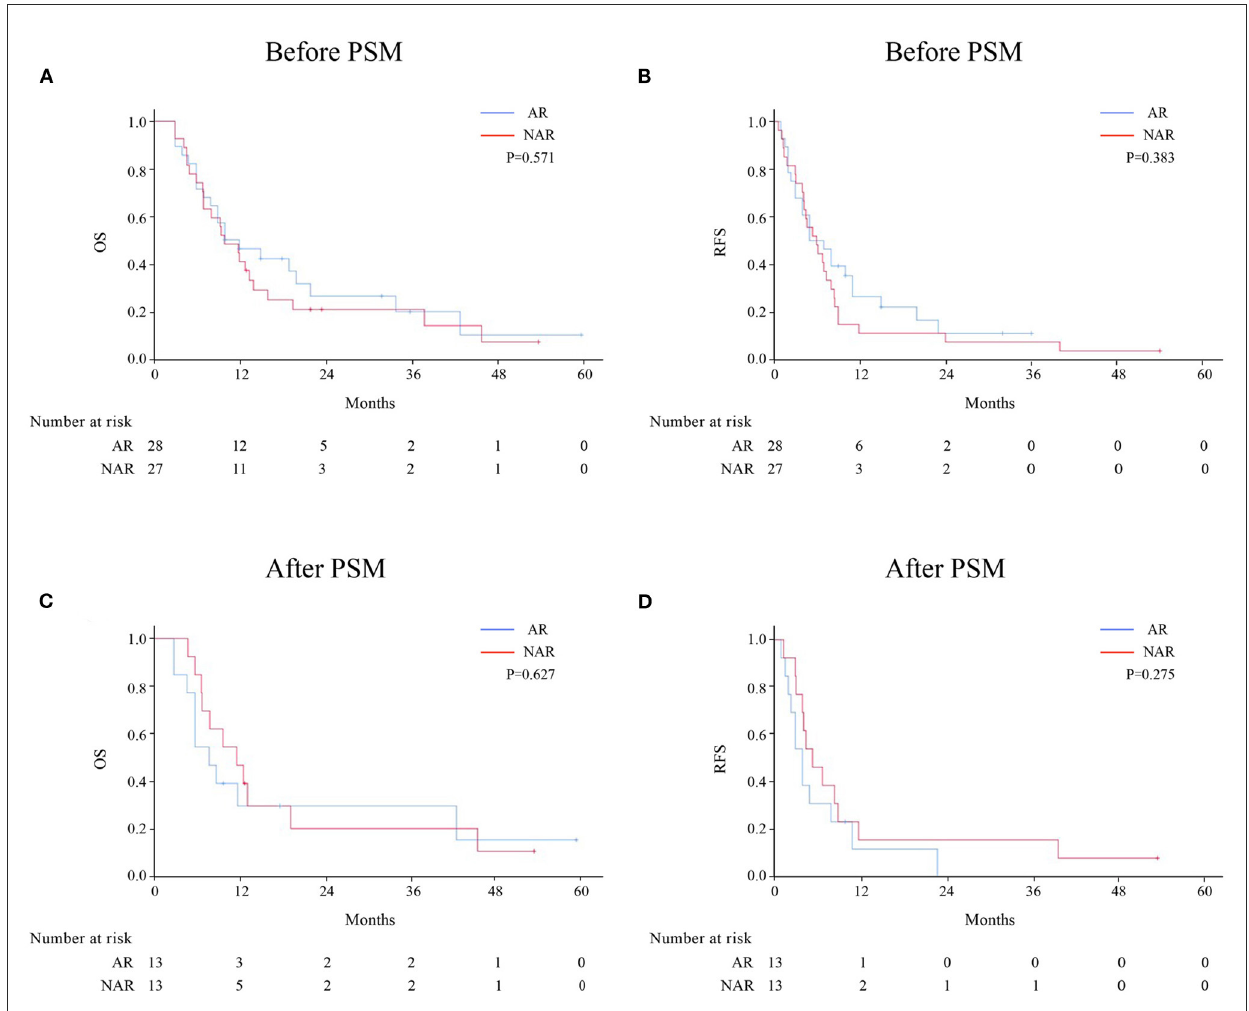
FIGURE3 OS and RFS rates after AR vs. NAR for HICC patients with LNM before (A, B) and after PSM (C, D) .